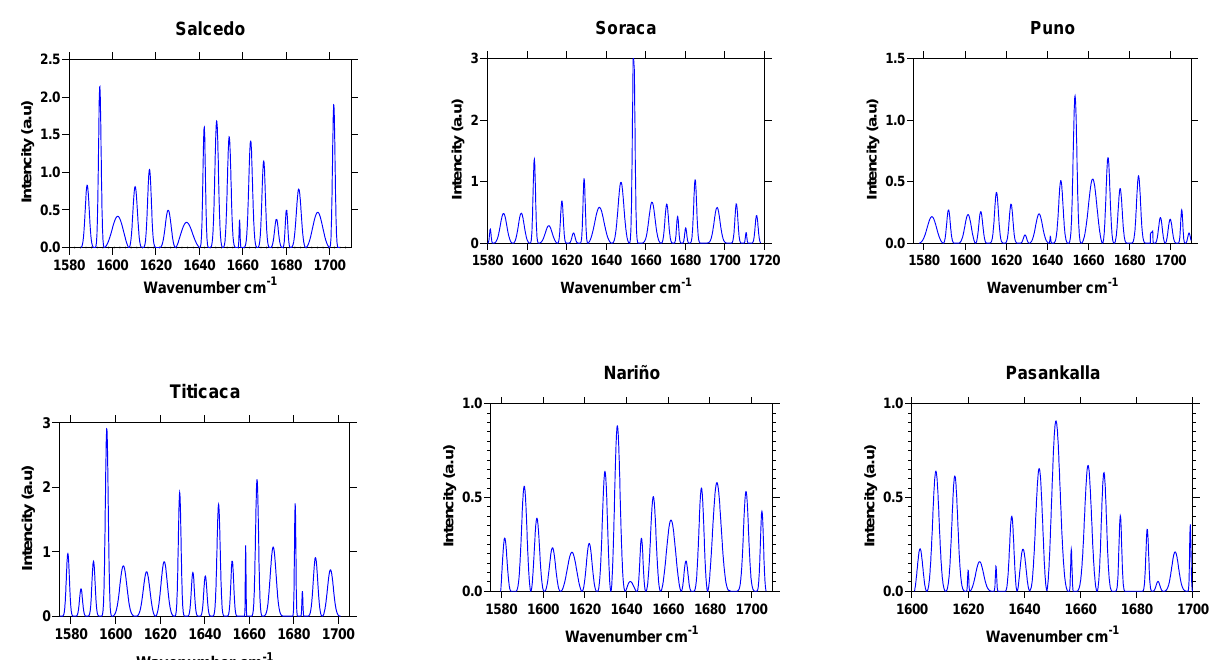
Figure 4. Protein secondary structures of quinoa grains from Colombian cultivars through the deconvolution FTIR tech- nique.